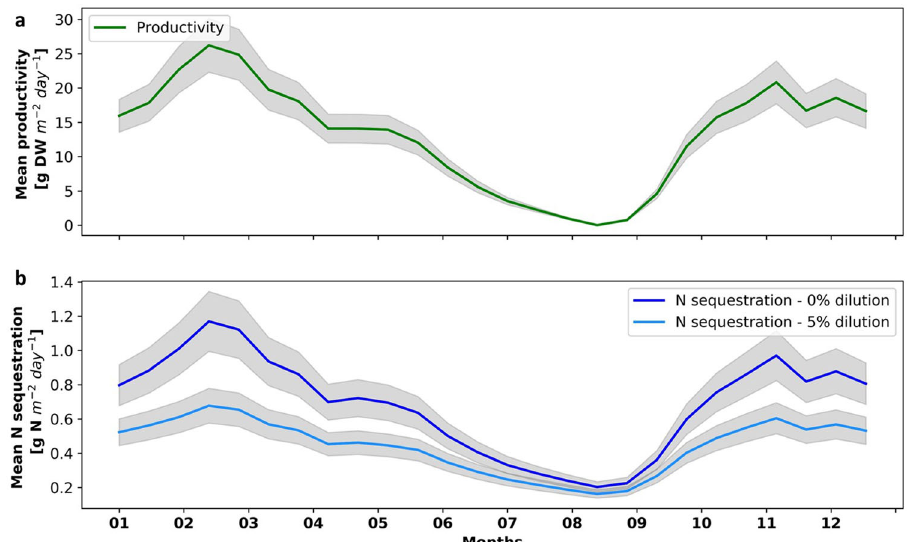
Fig. 3 Year-round distribution of mean productivity and N sequestration in a seaweed farm, in two levels of simulated dilutions. a Mean productivity (gDWm − 2 day − 1 , green). b mean nitrogen sequestration (gNm − 2 day − 1 ) in a non-diluting environment ( d = 0, dark blue) and a diluting environment ( d = 0.05, 5% dilution between each two reactors, light blue) vs time of the year for a farm of 100 reactors. Shaded region represents a 15% calibration error.